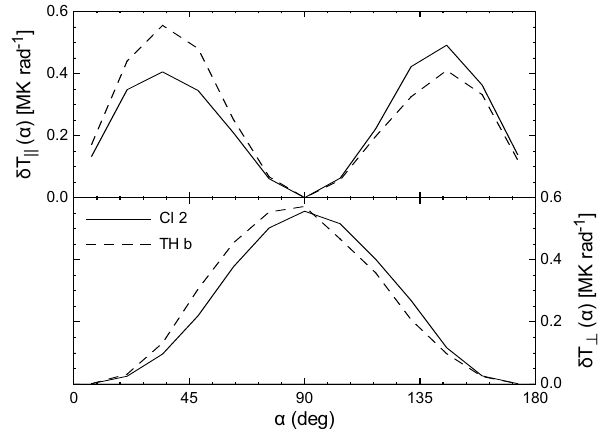
Table 2. Rankine-Hugoniot total temperatures (in units of 10 6 K), Mach numbers and electron temperature ratios at bowshock cross- ing points corresponding to different energy and pitch angle elec- trons arriving at the position of THEMIS b and Cluster 2.